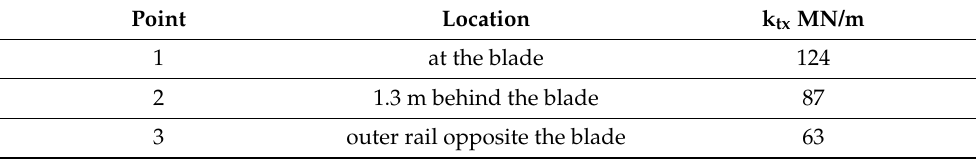
Table 7. Mean values of the stiffness coefficient of the